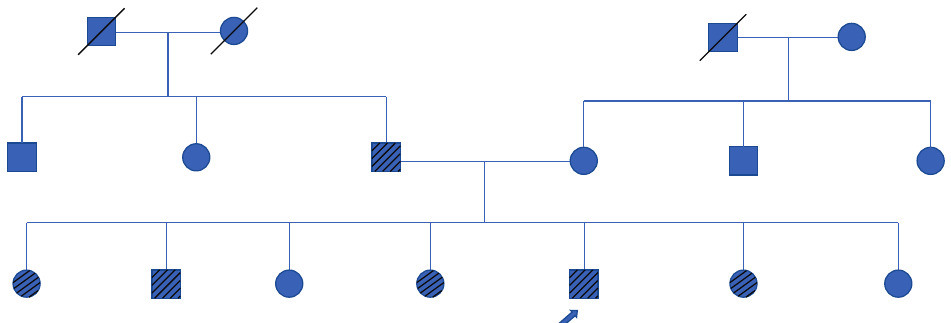
Figure 1: Family pedigree. Squares represent male family members; circles represent female family members; multiple-slashed symbols represent affected members; single-slashed symbols represent deceased members. The arrow points to the